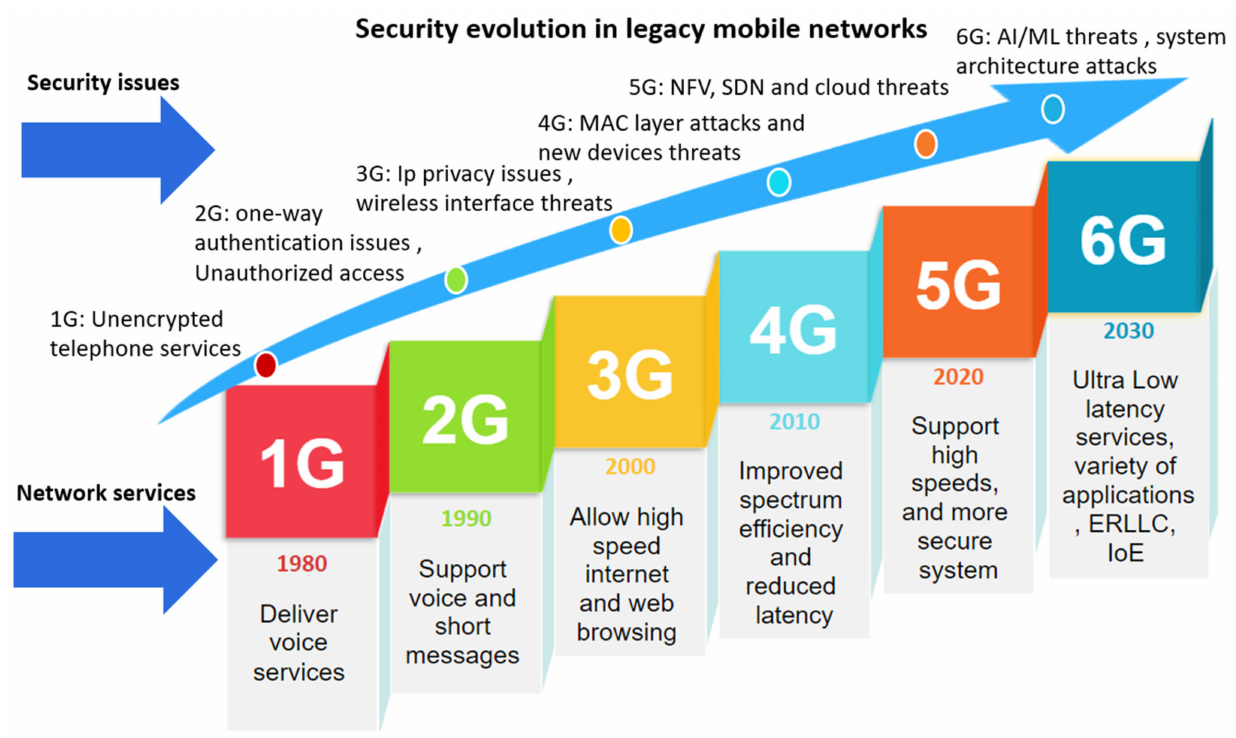
Figure 2. The security evolution of mobile communications from 1G to the predicted future